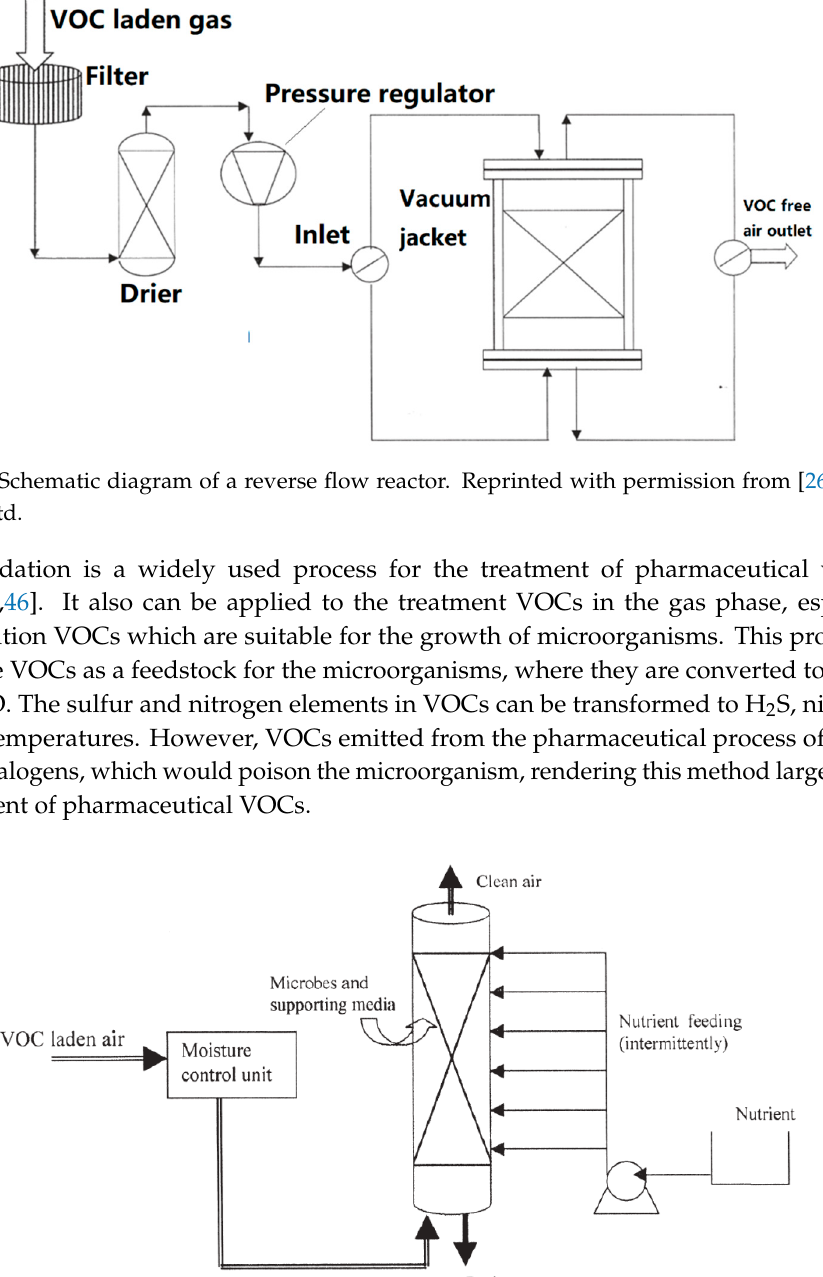
Figure 5. Scheme of catalytic oxidation. Reprinted with permission from [26], 2000, Elsevier Ltd.